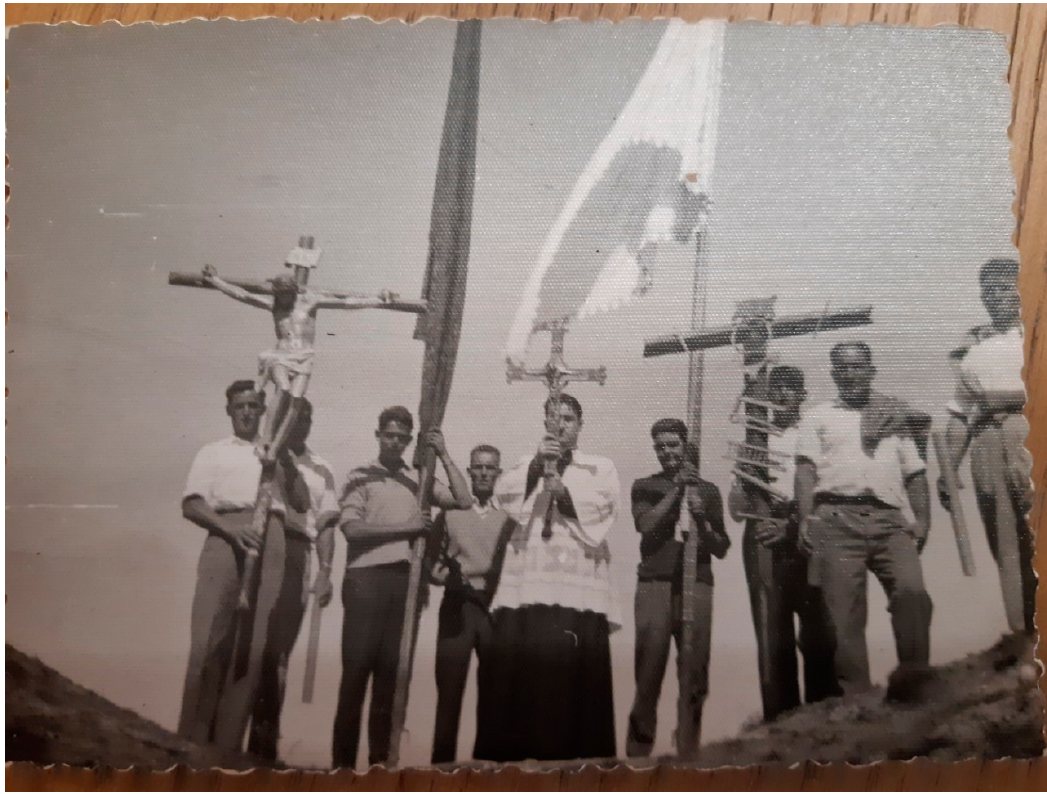
Figure 3. Procession to Monjardin in 1962. Source: Private Archive of Carmelo San Martin.